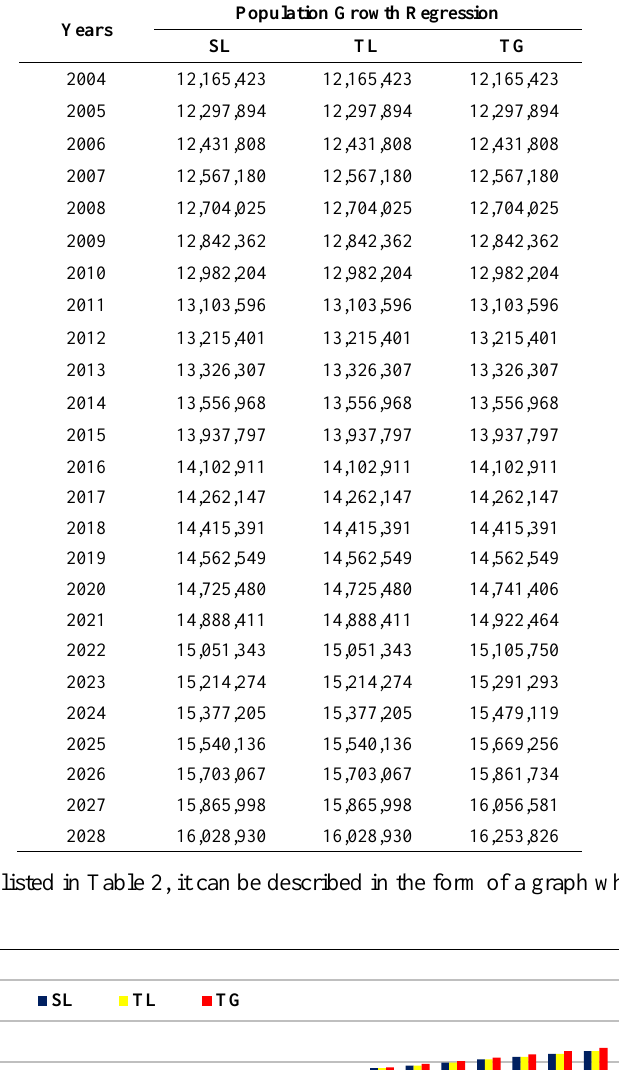
Table 2. Test results using Simple E